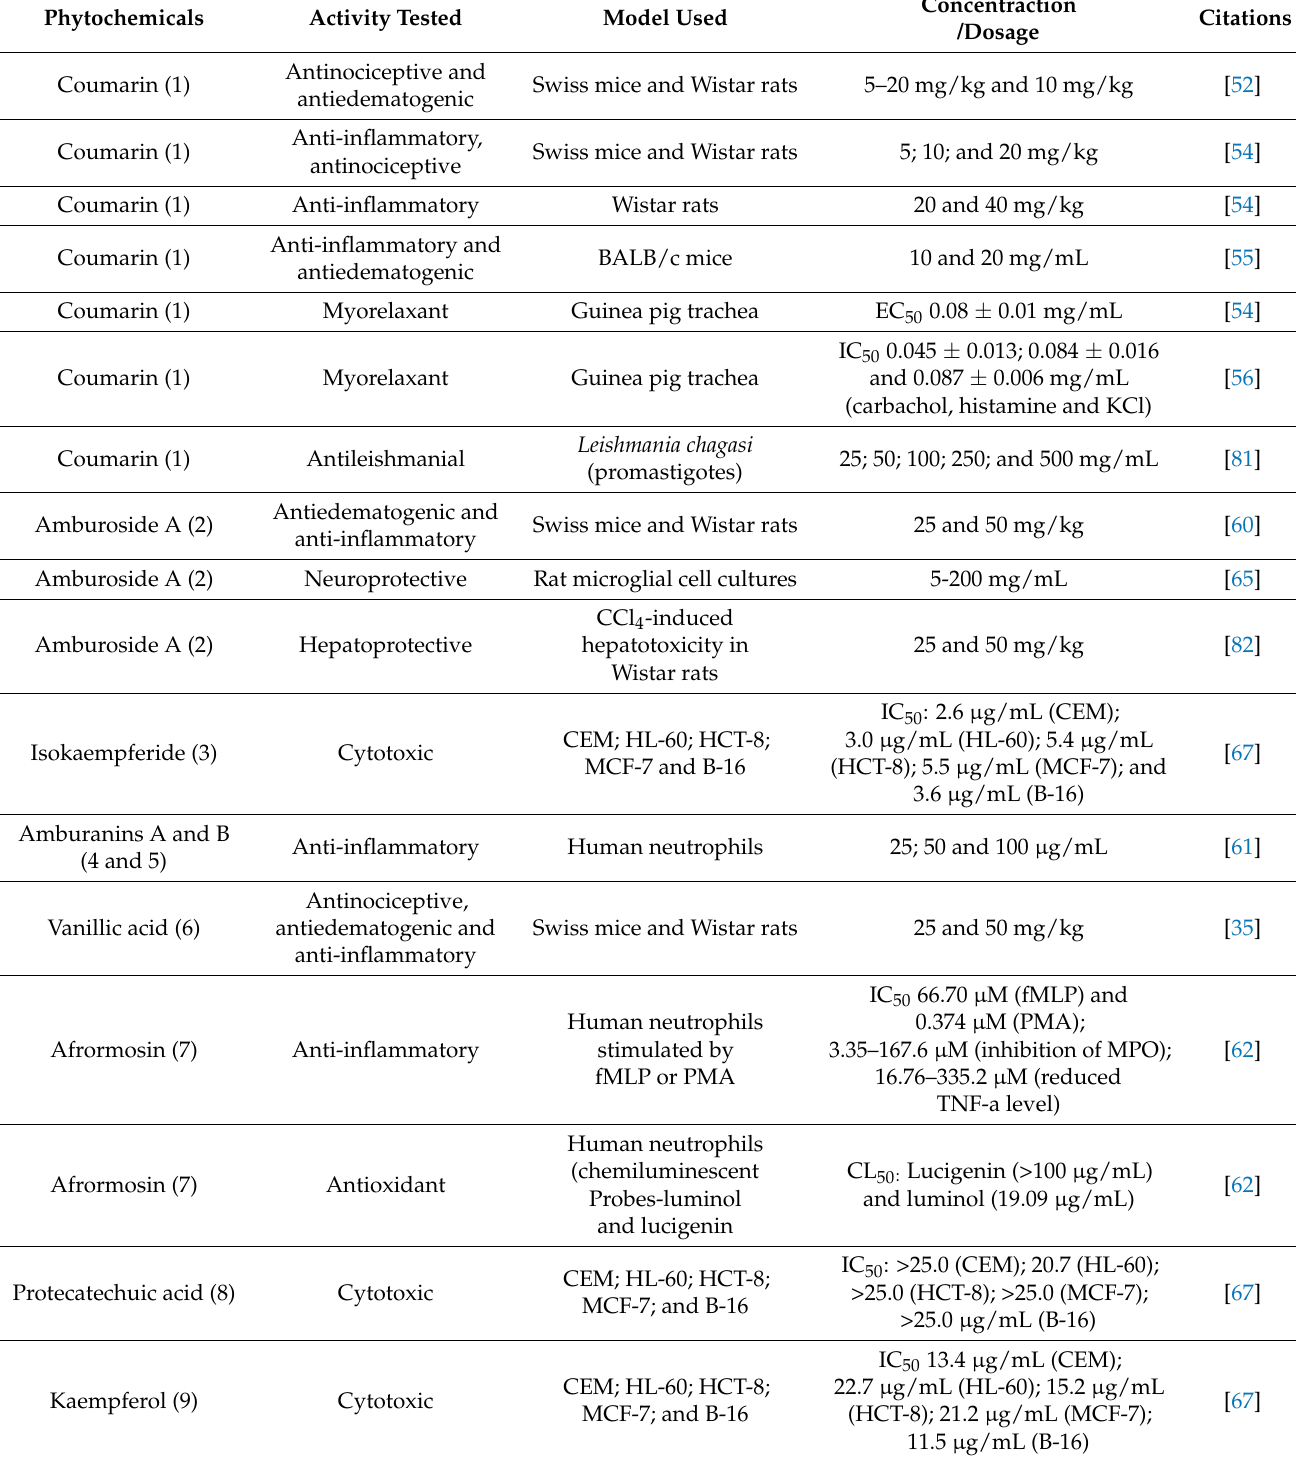
Table 3. Biological activities of compounds isolated from A. cearensis